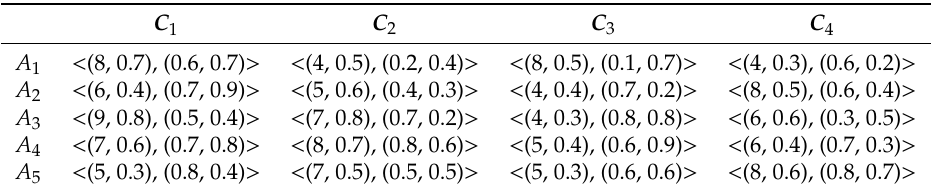
Table 1. Initial decision matrix.